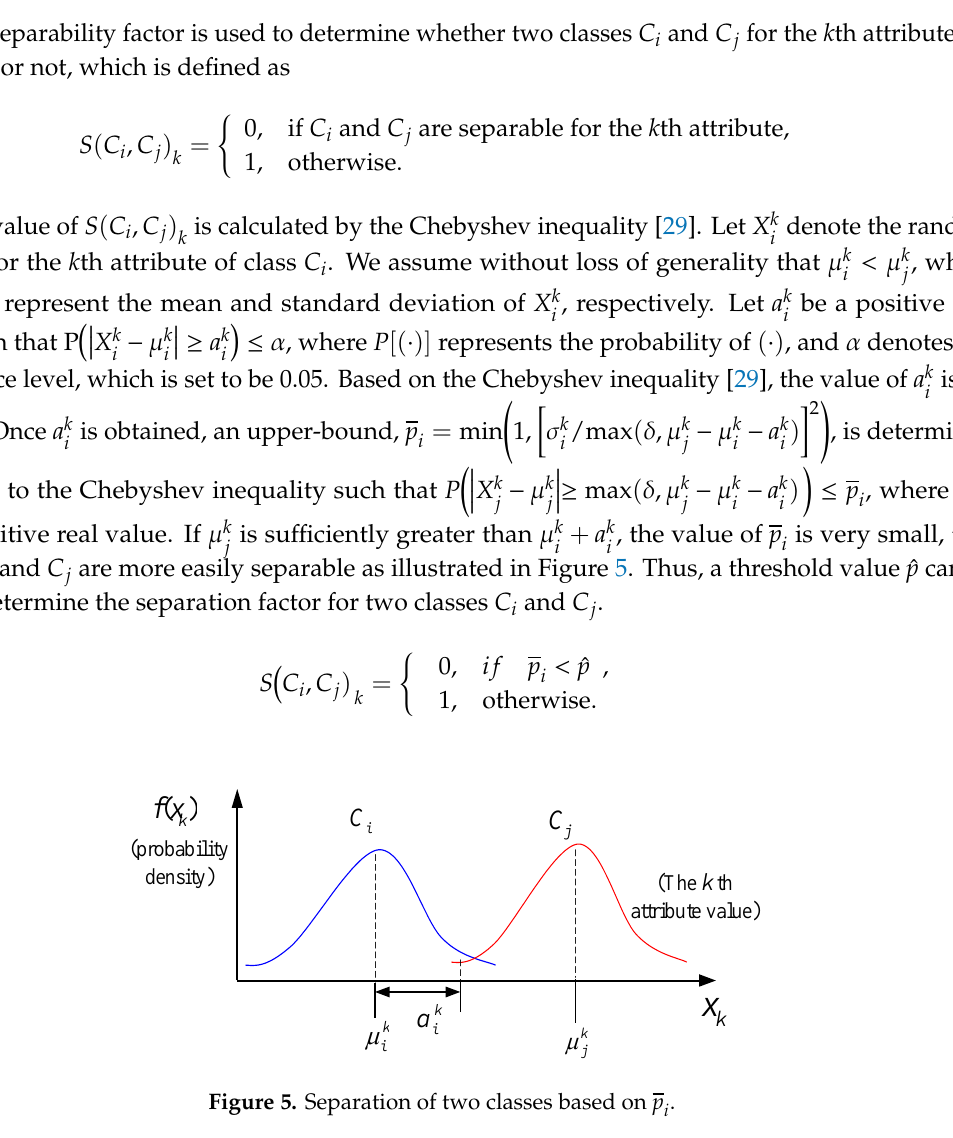
Figure 4. Classes Figure 4. Classes C i and C j are not separable.